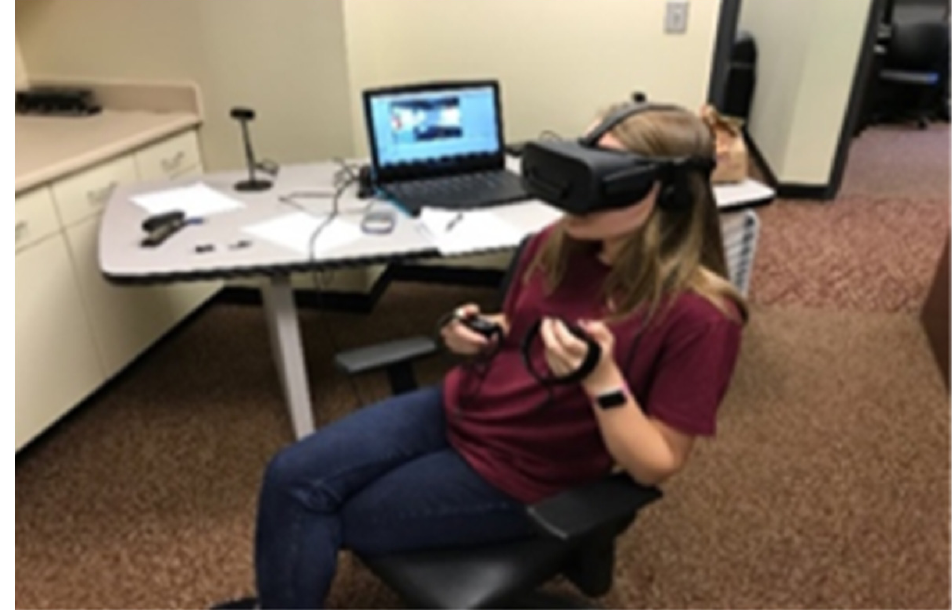
Figure 2. Oculus rift headset and data collection.